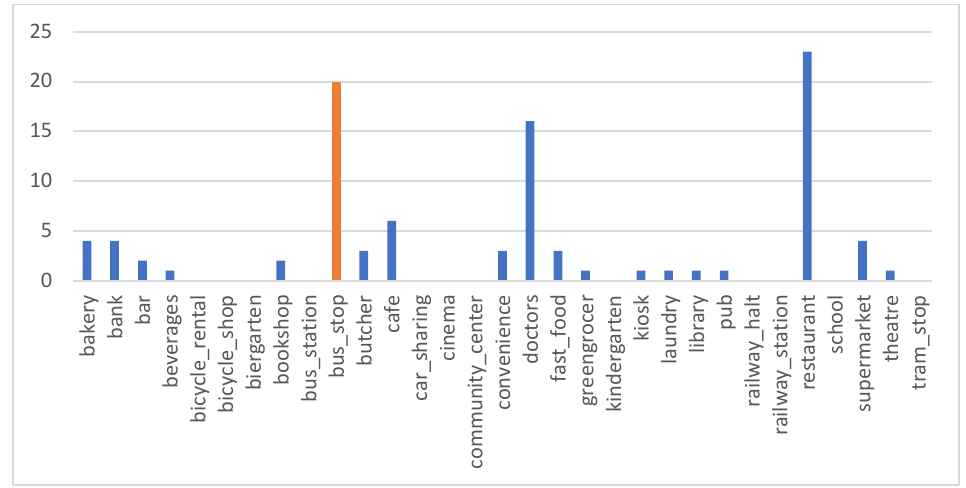
Figure 18. Number of POIs in the vicinity of 500 m in the surrounding of the CWS EchtLand in Pfaffenhofen an der Ilm.